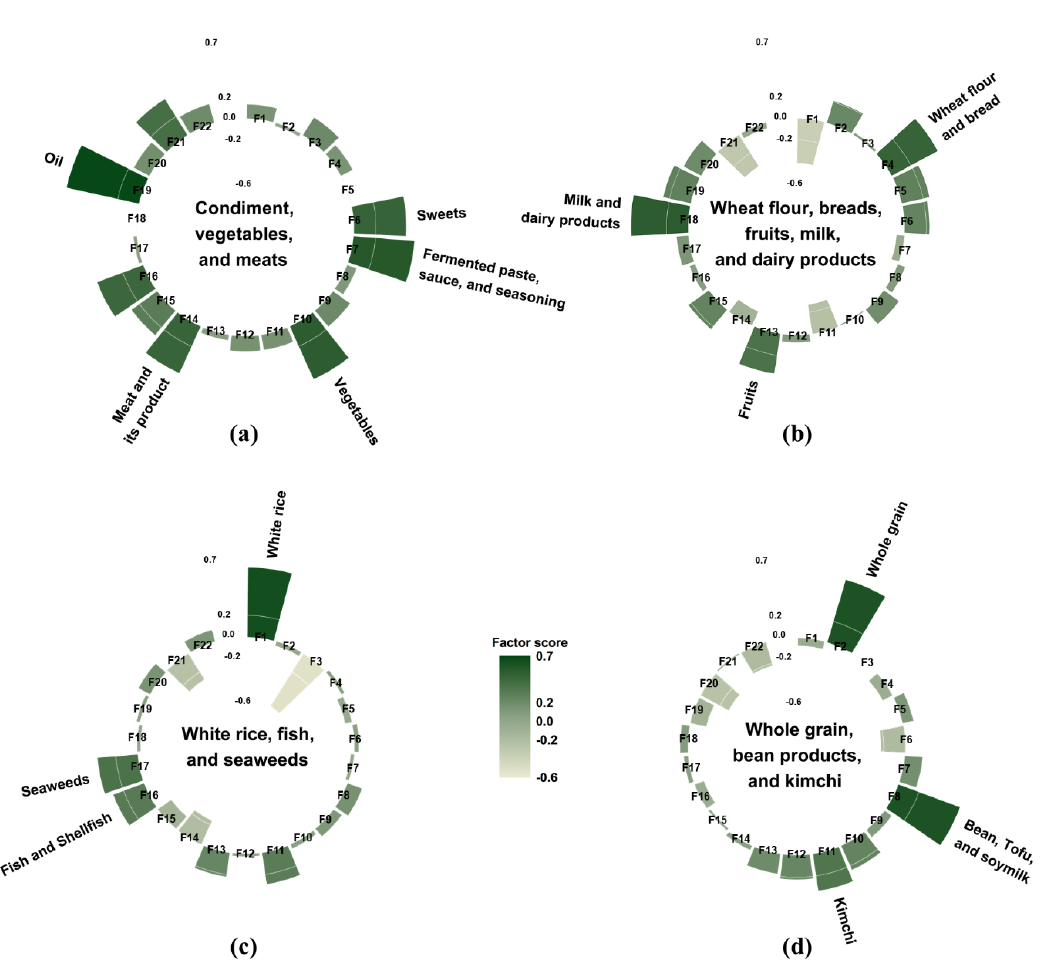
Figure 2. Factor loading matrix of food groups for the four dietary patterns identified from the 24-h dietary recall. ( a ) the “condiment, vegetables, and meats” pattern; ( b ) the “wheat flour, breads, fruits, milk, and dairy products” pattern; ( c ) the “white rice, fish, and seaweeds” pattern; and ( d ) the “whole grain, bean products, and kimchi” pattern. The top three food groups with the highest factor loading value were used to name each dietary pattern. As an exception, oils, fermented paste, sauce, and seasoning, and sweets were grouped into condiments and used for naming the “condiment, vegetables, and meats” pattern. F1: white rice, F2: whole grain, F3: noodles and dumpling, F4: wheat flour and bread, F5: potatoes and corn, F6: sweets, F7: fermented paste, sauce, and seasoning, F8: bean, tofu, and soymilk, F9: nuts and seeds, F10: vegetables, F11: kimchi, F12: mushroom, F13: fruits, F14: meat and its product, F15: eggs, F16: fish and shellfish, F17: seaweeds, F18: milk and dairy products, F19: oil, F20: beverage, F21: alcohol, F22: coffee and tea.